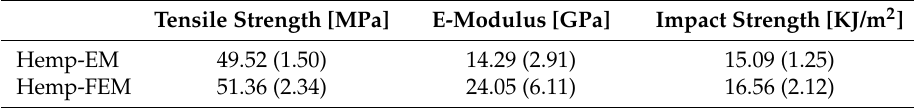
Table 4. E-modulus, tensile and impact strength of the different hemp/PLA